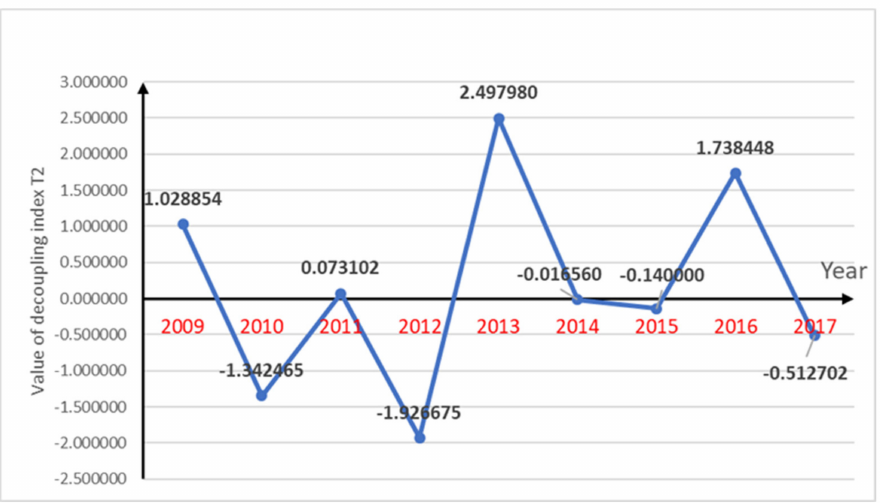
Figure 3. Decoupling index changes of T 2 along with period of